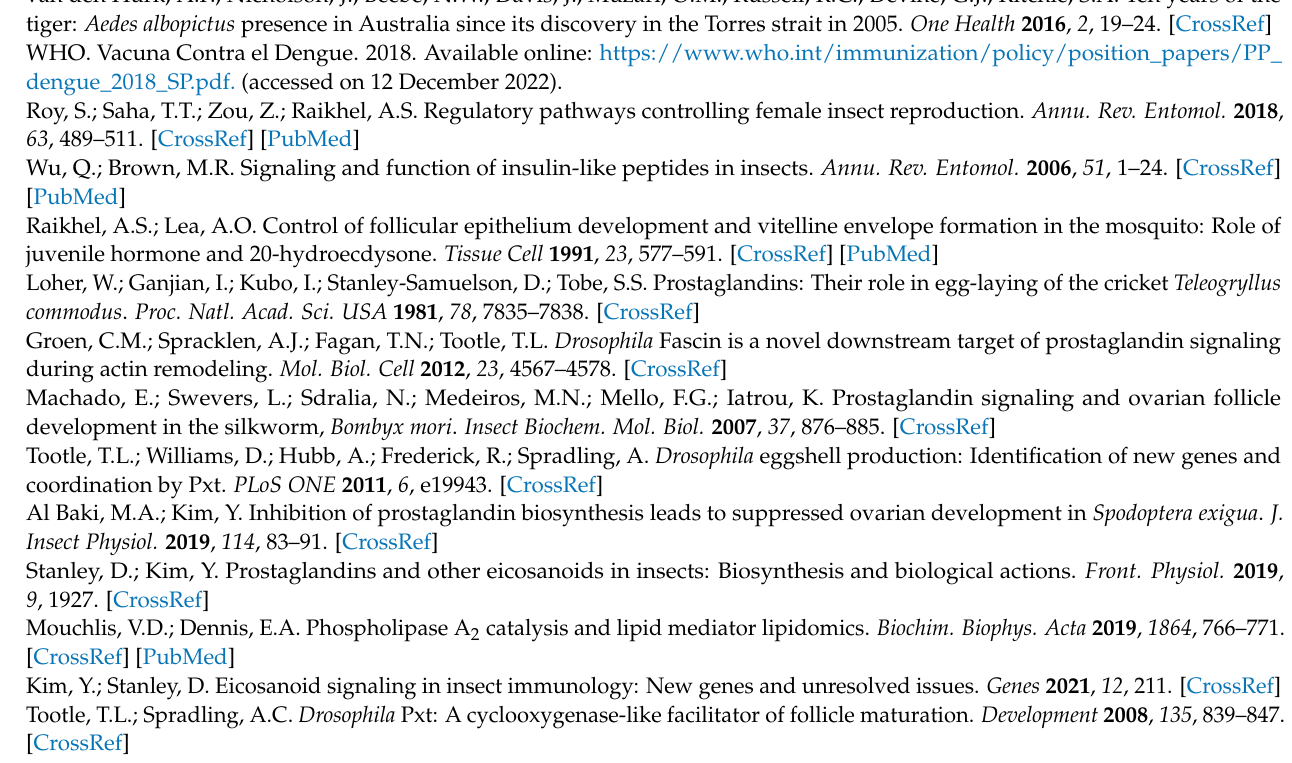
Figure S1: Effects of different concentrations of aspirin (‘ASP’) on choriogenesis of Ae. albopictus ; Figure S2: Identification of six PLA 2 genes of Ae. albopictus ; Figure S3: Prediction of peroxidases (POXs) associated with PG biosynthesis in Ae. albopictus ; Figure S4: Phylogenetic tree and domain analyses of Aa-Shade ; Figure S5: RNAi of three PLA 2 ( Aa-PLA 2 -IIA , Aa-PLA 2 -IIIB , Aa-PLA 2 -VI ) and three POX ( Aa-POX19 , Aa-POX20 , Aa-POX15 ) genes; Figure S6: Molecular characteristics of Ae. albopictus PGE 2 receptor (Aa-PGE 2 R: GenBank accession number: XP_029736412.1); Figure S7: Expression profile of PGE 2 R in Ae. albopictus ; Figure S8: Molecular characterization of Ae. albopictus vitellogenin protein ( Aa-Vg1 and Aa-Vg2